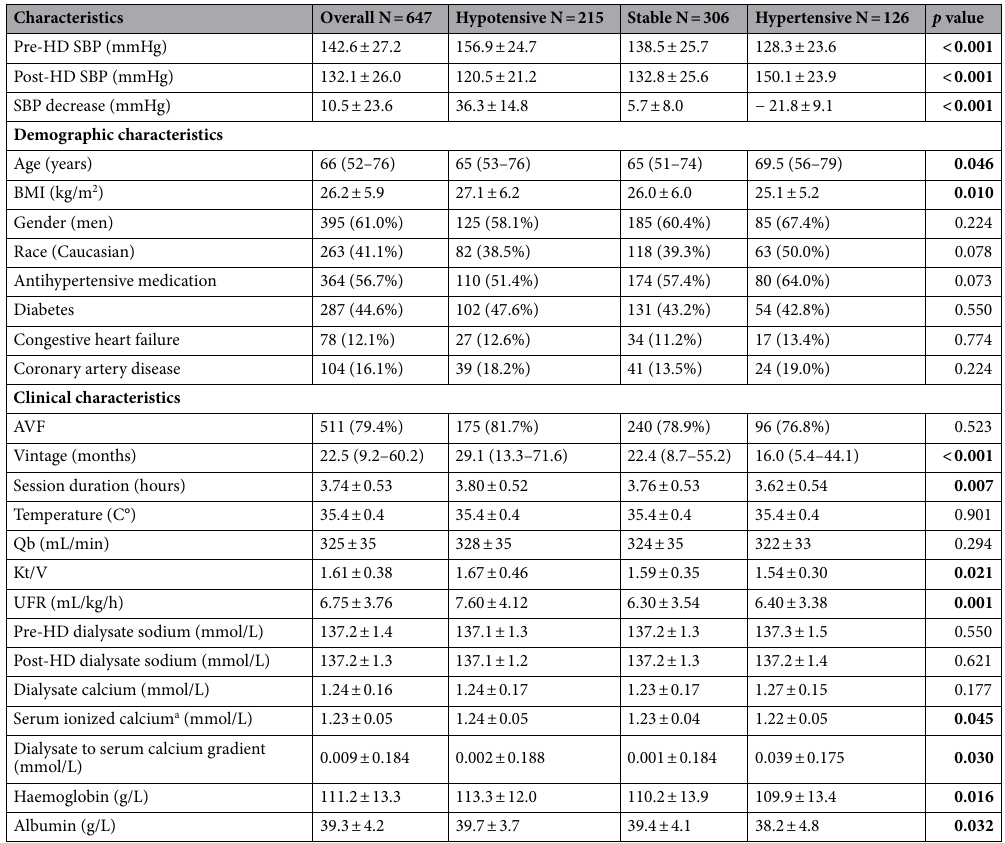
Table 1. Patients characteristics according to peridialytic SBP trends. SBP systolic blood pressure, BMI body mass index, AVF arteriovenous fistula, Qb blood flow, UFR ultrafiltration rate, HD haemodialysis. a Calculated as 0.815 * (total serum calcium) 0.5 . Bold values correspond to p <